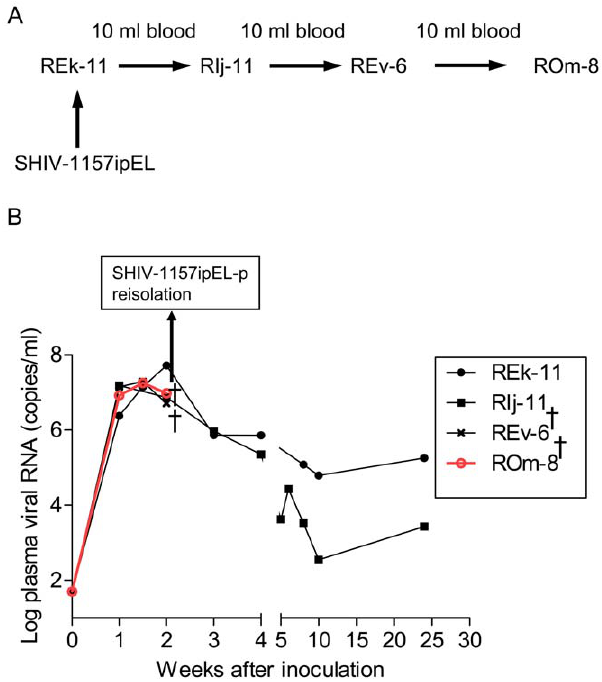
Figure 4. Serial passage of SHIV-1157ipEL in rhesus macaques. (A) Parental SHIV-1157ipEL was passaged rapidly in four Indian-origin RM through serial blood transfer at peak viremia (week 2). (B) Viral loads were measured after serial passage at the time points indicated. { , these RM were euthanized at peak viremia.